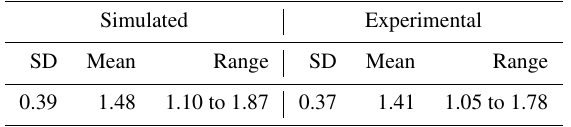
Table 11. Temperature – Simulated verses experimental